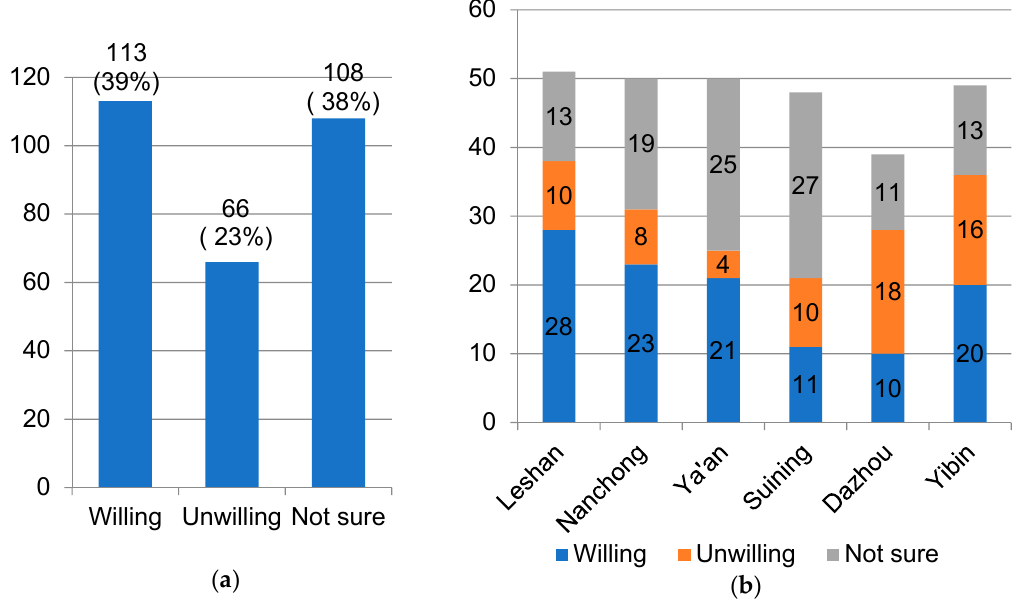
Figure 3. Urban residents’ willingness to participate in the vacant farmhouse market. ( a ) Urban residents' willingness: total; ( b ) Urban residents' willingness: different cities.